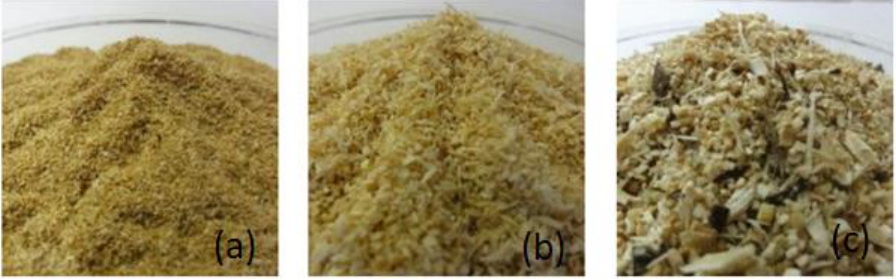
Figure 9. Different batches of sawdust used ( a ) (less than 0.7 mm), ( b ) (between 0.7 and 1.4 mm) and ( c ) (between 1.4 and 2.8 mm). From the project EcoPlast. ( c ) (between 1.4 and 2.8 mm). From the project